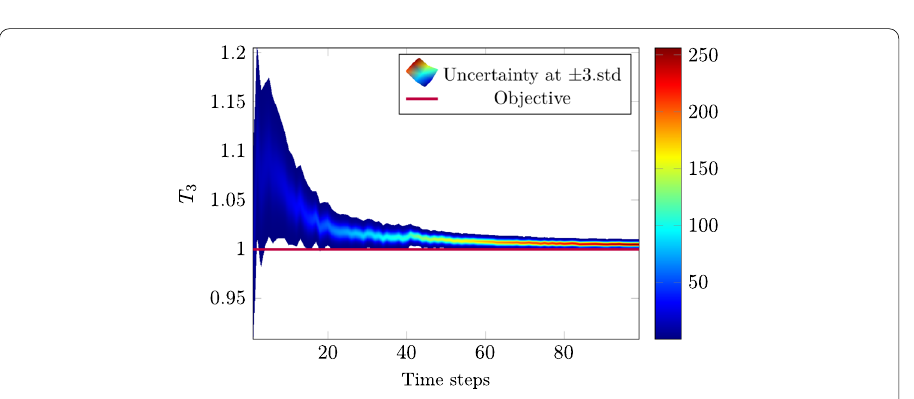
Fig. 20 Evolution in time of T 3 | t when the control is implemented - Case 2